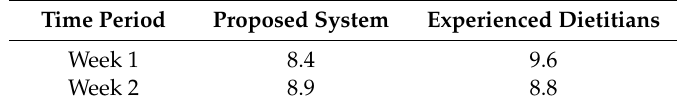
Table 4. Comparison results of the proposed system and the experienced dietitians on MDA scoring.